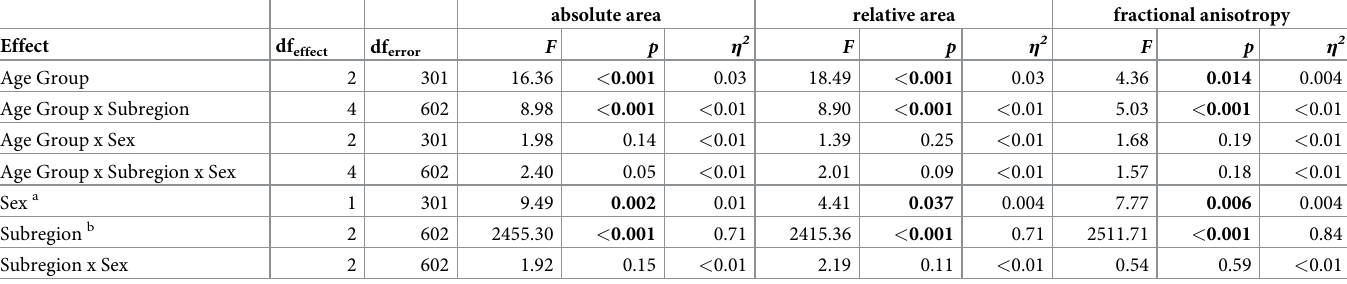
Table 2. Aging and the corpus callosum. Results of the three analyses of variance with the three factors age group (young, middle, older), sex (male/female), and subre- gion (within factor: genu, truncus, posterior third) and using the dependent measure absolute area, relative area (absolute area/tIV 0.667 ratio) and fractional anisotropy (FA),